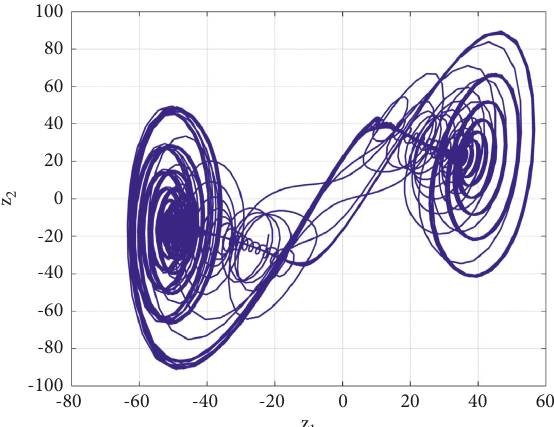
Figure 5: A chaotic attractor of the model (1) for a � 11 and ( b, c, d ) � ( 8 , 90 , 6 )